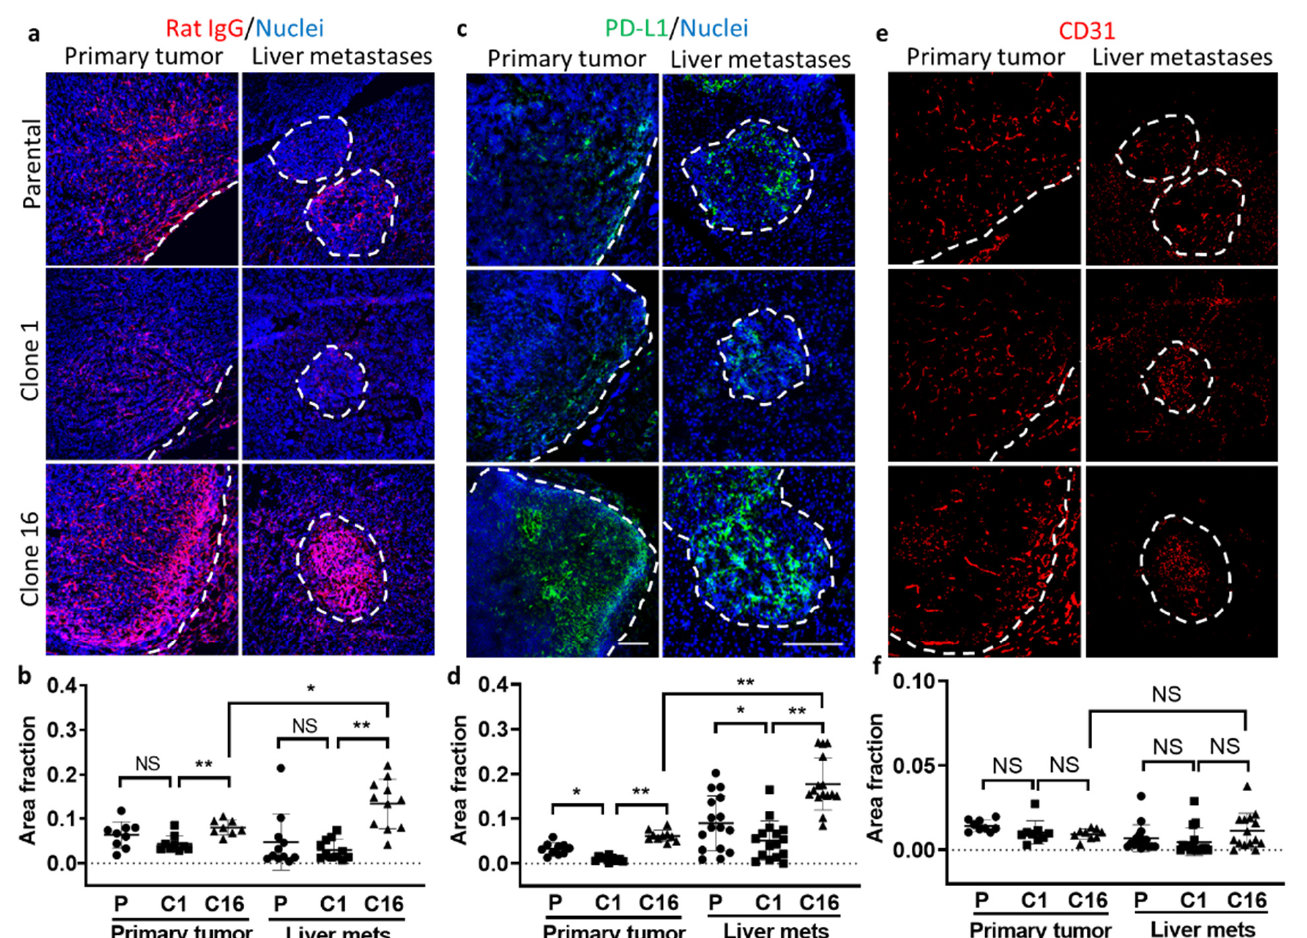
Figure 5. Immunohistochemical analyses of primary tumor and liver metastases. Immunofluorescence imaging ( a ) and quantification ( b ) of delivery of iv injected rat anti-PD-L1 IgG to tumors by immunostaining using the antibody against rat IgG. Immunofluorescence imaging ( c ) and quantification ( d ) of PD-L1 expression in parental-, clone-1-, clone-16-derived primary tumors and liver metastases using the antibody against PD-L1. Immunofluorescence imaging ( e ) and quantification ( f ) of vasculature in primary tumor and liver metastases using the antibody against CD31 (* p < 0.05; ** p < 0.001; NS: no significant difference). Scale bar, 100 µ